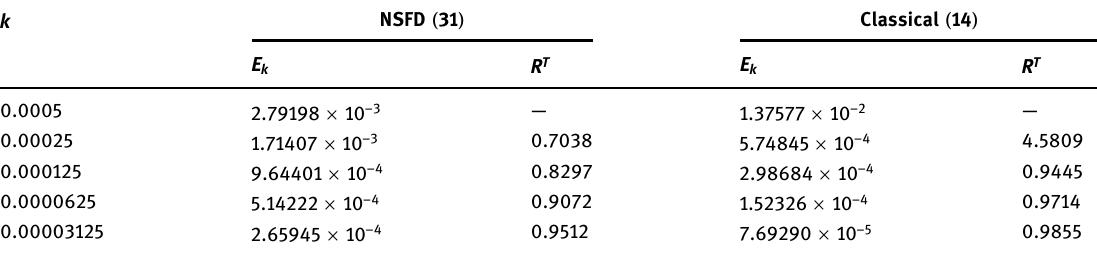
Table 5: Rate of convergence in time using experiment 4 for NSFD and classical for = h 0.02 at time = t